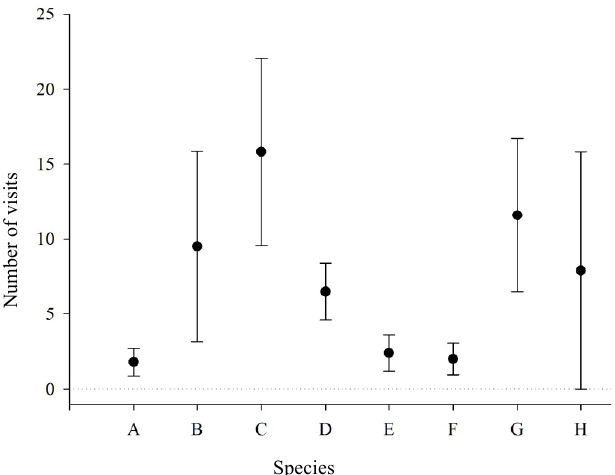
Fig 5. Abundance of visits of species in Ipomoea bahiensis (Convolvulaceae) between 8:00 and 9:00 h, in Feira de Santana (BA). Species represented: (A) Ancyloscelis apiformes ; (B) Apis mellifera ; (C) Melitoma spp.; (D) Morys compta compta ; (E) Nyctelius nyctelius nyctelius ; (F) Phoebis sennae marcellina ; (G) Pseudaugochlora pandora ; (H) Synale hylaspes. (n > 10 visits) (Complete table with all visitors in Araujo et al .,